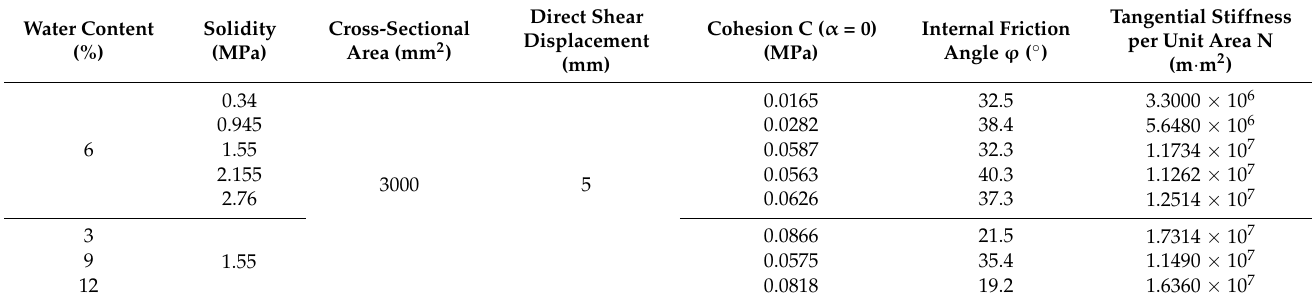
Table 2. Results of direct shear tests on soil with different moisture content and